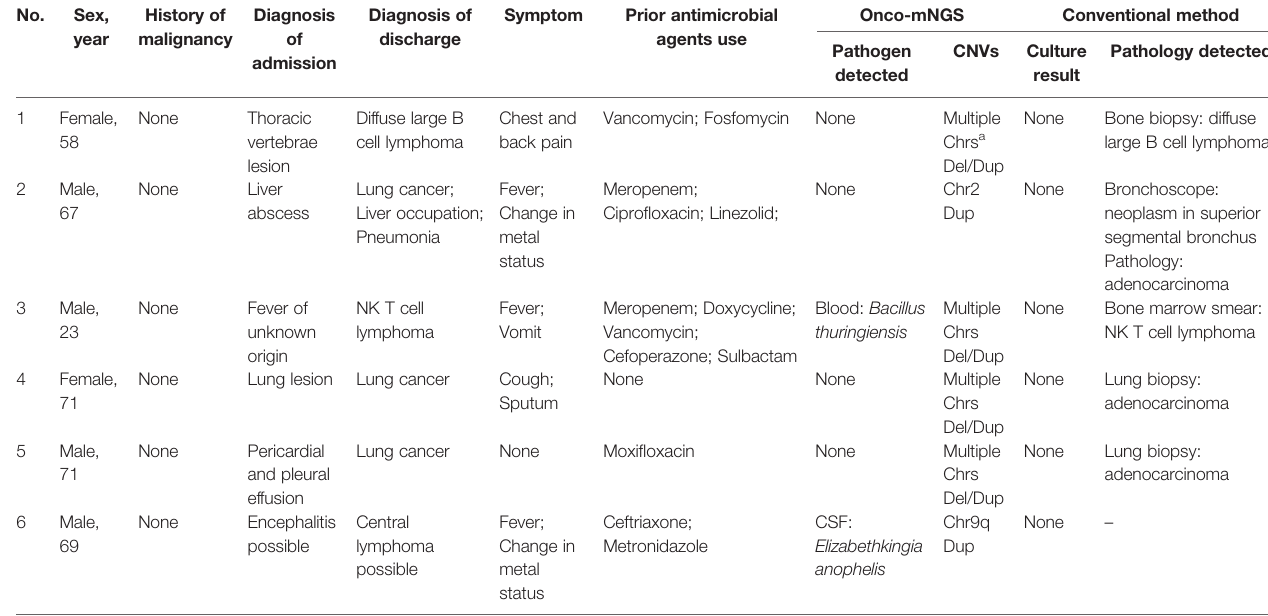
TABLE 2 | Clinical characteristics of patients with CNV changes and no history of malignancy before mNGS testing.